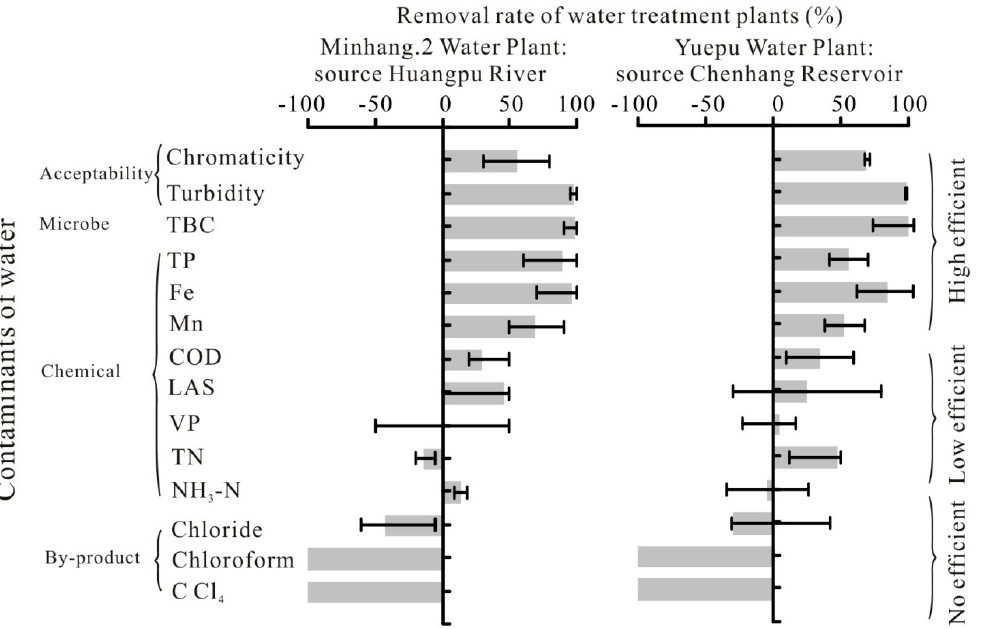
Figure 5. The removal rates 14 contaminants at two typical water treatment plants: ( A ) the Minhang No. 2 water plant, and ( B ) the Yuepu water plant. Negative values indicate increase, not removal.